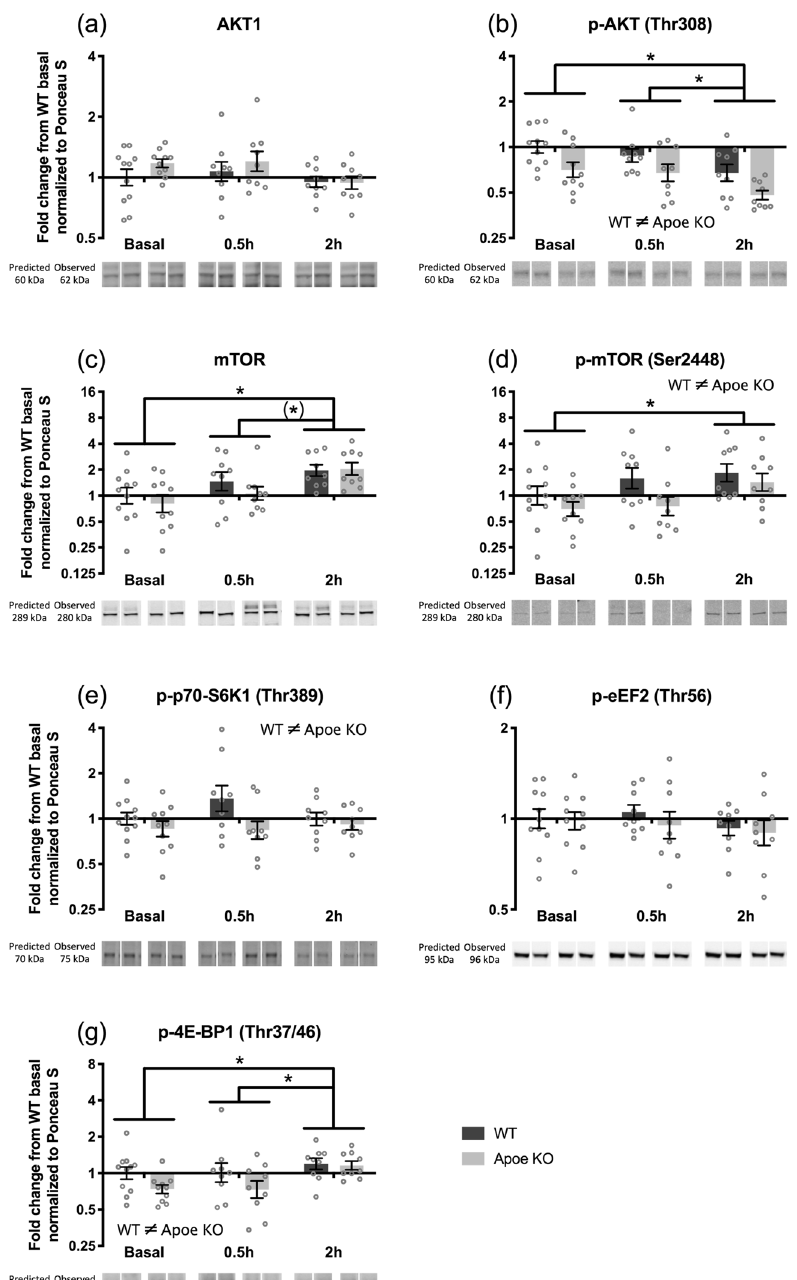
Figure 6. Hypertrophy signaling pathway during the acute trial. Protein expression of AKT1 ( A ), p-AKT(Thr308) ( B ), mTOR ( C ), p-mTOR(Ser2448) ( D ), p-p70-S6K1(Thr389) ( E ), p-eEF2(Thr56) ( F ), and p-4E-BP1(Thr37/46) ( G ) in WT (dark bars) and Apoe KO (grey bars) mice at basal (WT n = 12, Apoe KO n = 10), 0.5 h (WT n = 9, Apoe KO n = 9) and 2 h (WT n = 9, Apoe KO n = 9) after whey protein ingestion. Data were normalized to Ponceau S and expressed as fold change from WT basal and individual values are shown with bars indicating geometric means ± back-transformed SEM. (*) trend for a difference between time points 0.05 ≤ p < 0.10, * difference between time points, p < 0.05. Samples were loaded in a randomized order, repeated twice on the same gel. Therefore, representative images of the bands were cropped and reorganized to represent the respective time point and mouse. Expected and observed band size are indicated for each